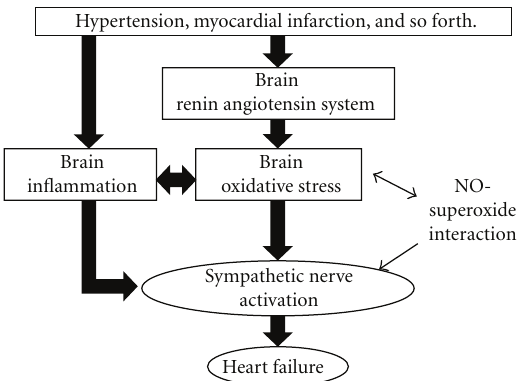
Figure 1: A schema of the concept in the central abnormalities of regulation for sympathetic nerve activity in chronic heart